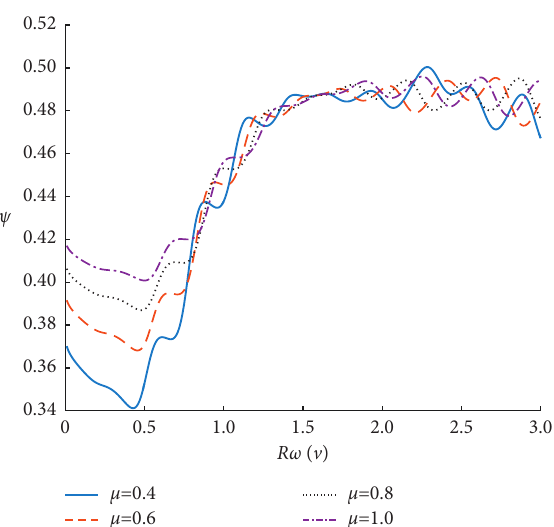
Figure 10: Curves of radial stress varying with frequency for different thickness of lining.